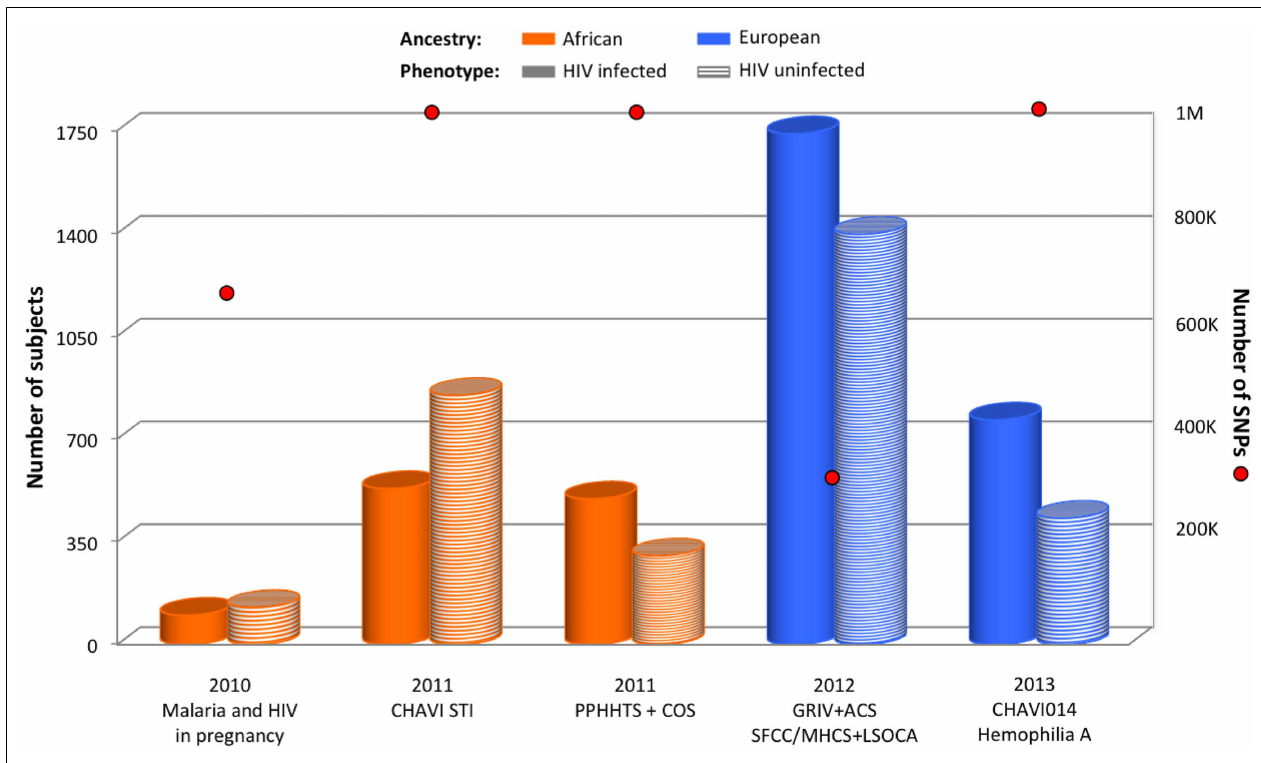
color-coded: orange for African and blue for European.The pattern of each cylinder illustrates the phenotype of interest: plain color for HIV-infected, and horizontal stripes for